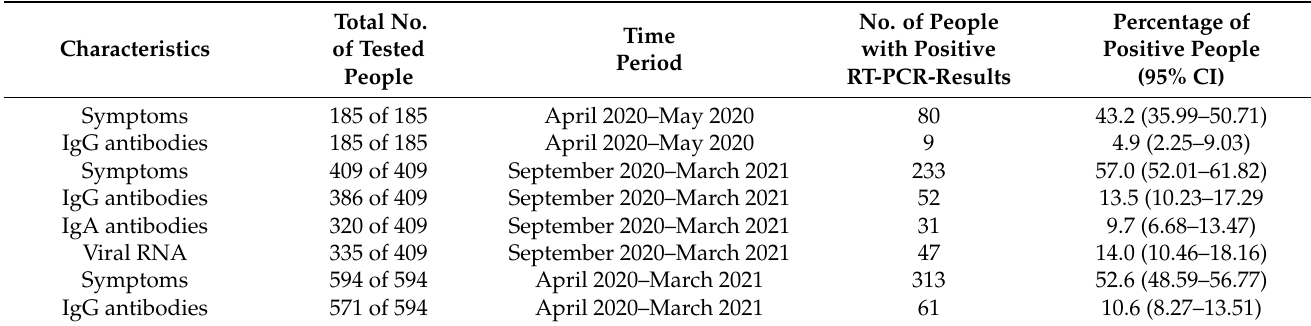
Table 2. Symptoms, seroprevalence, and RT-PCR positivity of participants with known COVID-19